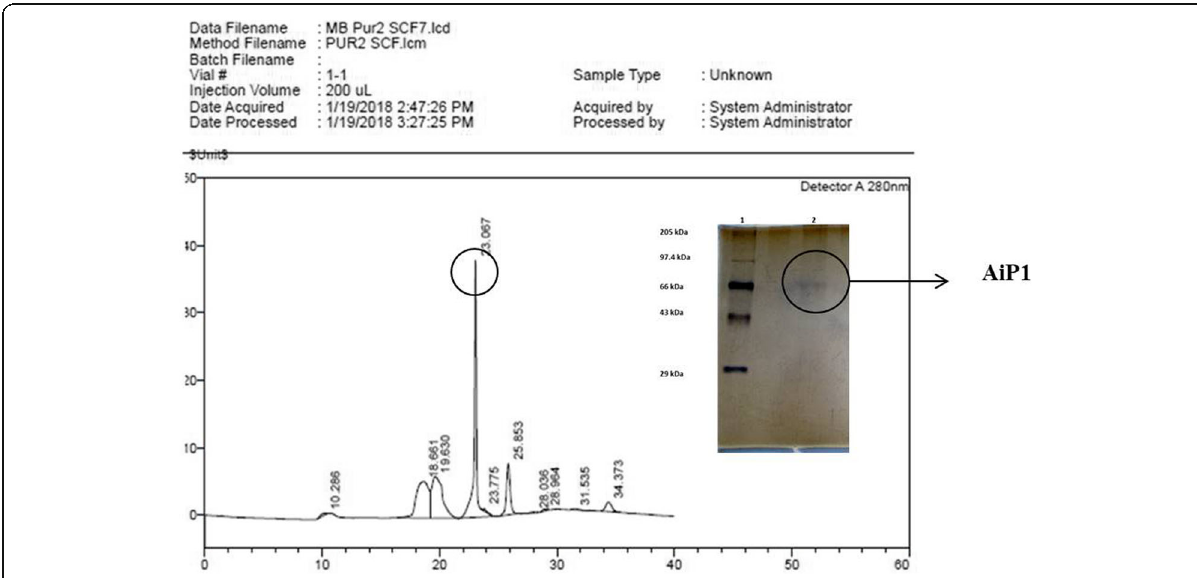
Fig. 3 Size exclusion HPLC of P-A: protein peak P-A was fractionated using HPLC on a size exclusion column. Flow rate = 0.5 ml/min; mobile phase = 50 mM KPB, pH 7.4. One sharp protein peak was eluted at retention time of 23 min. This peak was studied in detail in further sections. Inset is the protein purity and molecular weight estimation of AiP1. Lane 1 is high range protein molecular weight marker; lane 2 is AiP1. Molecular weight of AiP1 was estimated to be 66